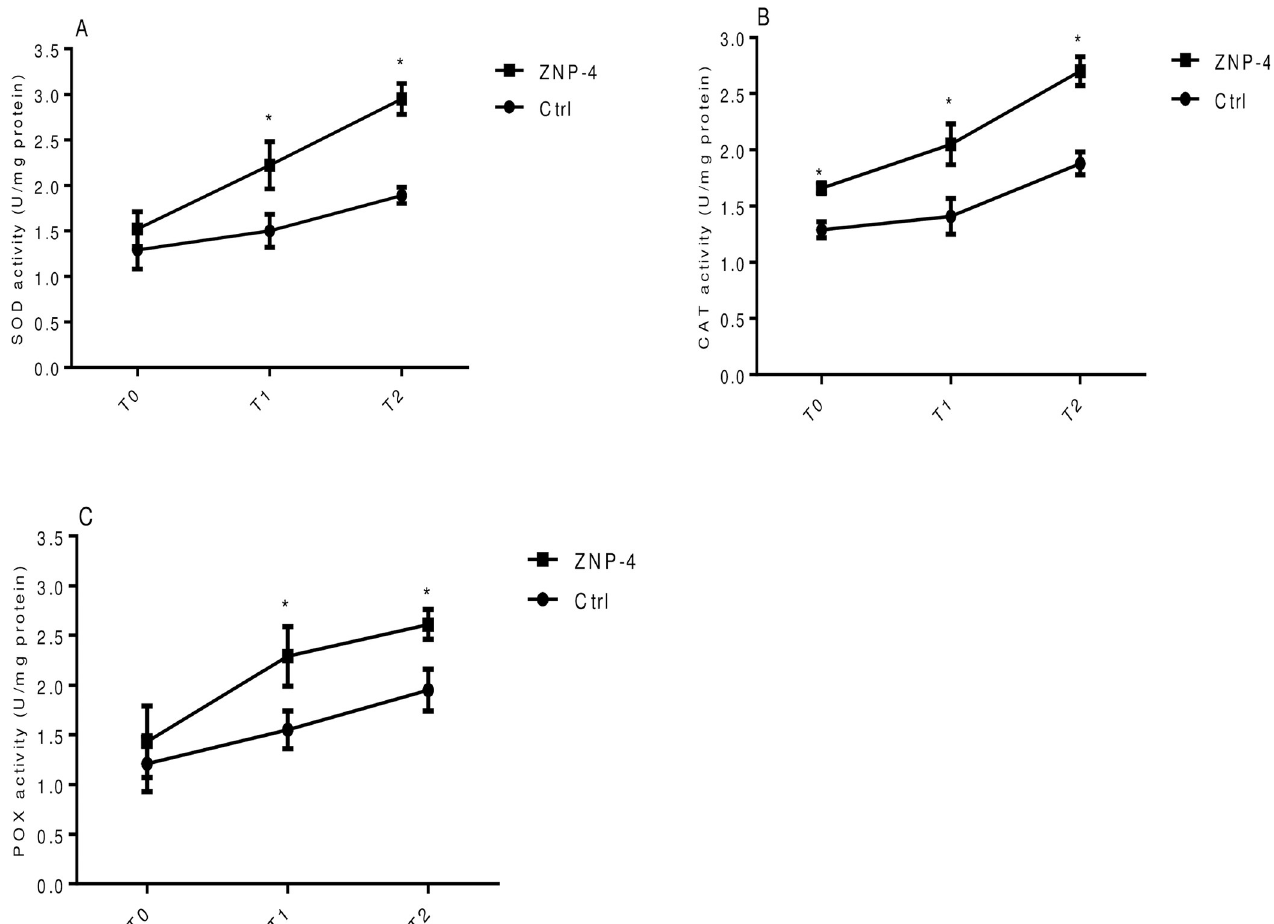
Fig 7. Effect of bacterium inoculation on antioxidative activities under tested metal stress (A) super-oxide dismutase (B) catalase (C) peroxidase. Each value represent the mean ± SD of triplicate sets (n = 15). The significant difference compared to corresponding control has been denoted by � . Error bar represent the standard deviation of triplicate sets with five measurement in each set (n =